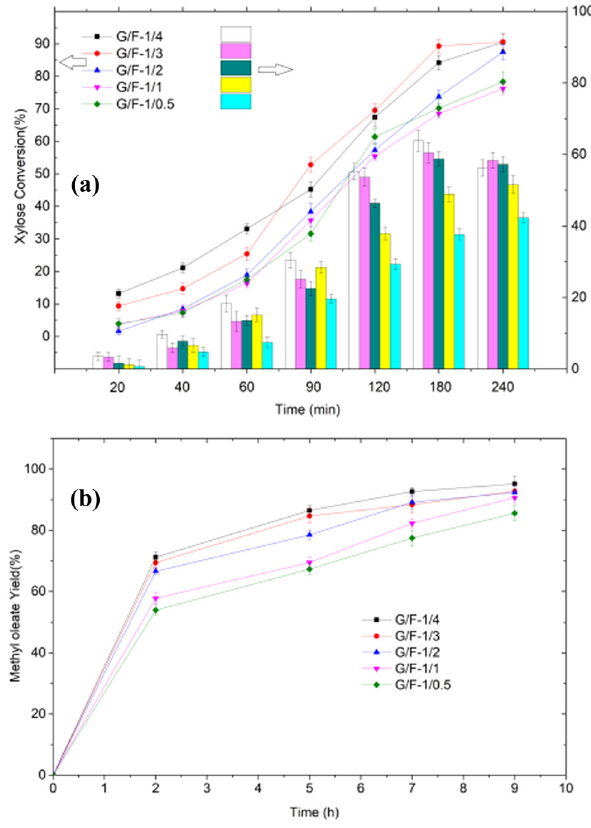
Figure 4: ( a ) Catalytic activities of the carbon solid acid catalysts